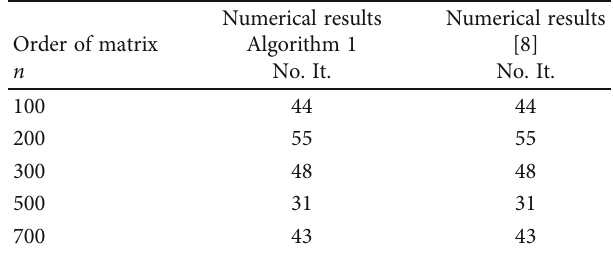
Table 1: For Algorithm 1 (numerical